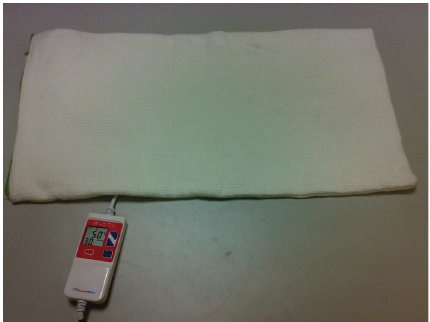
Figure 1: The photograph of the carbon fiber belt in this study. The belt controller was set to 50 ◦ C for 30